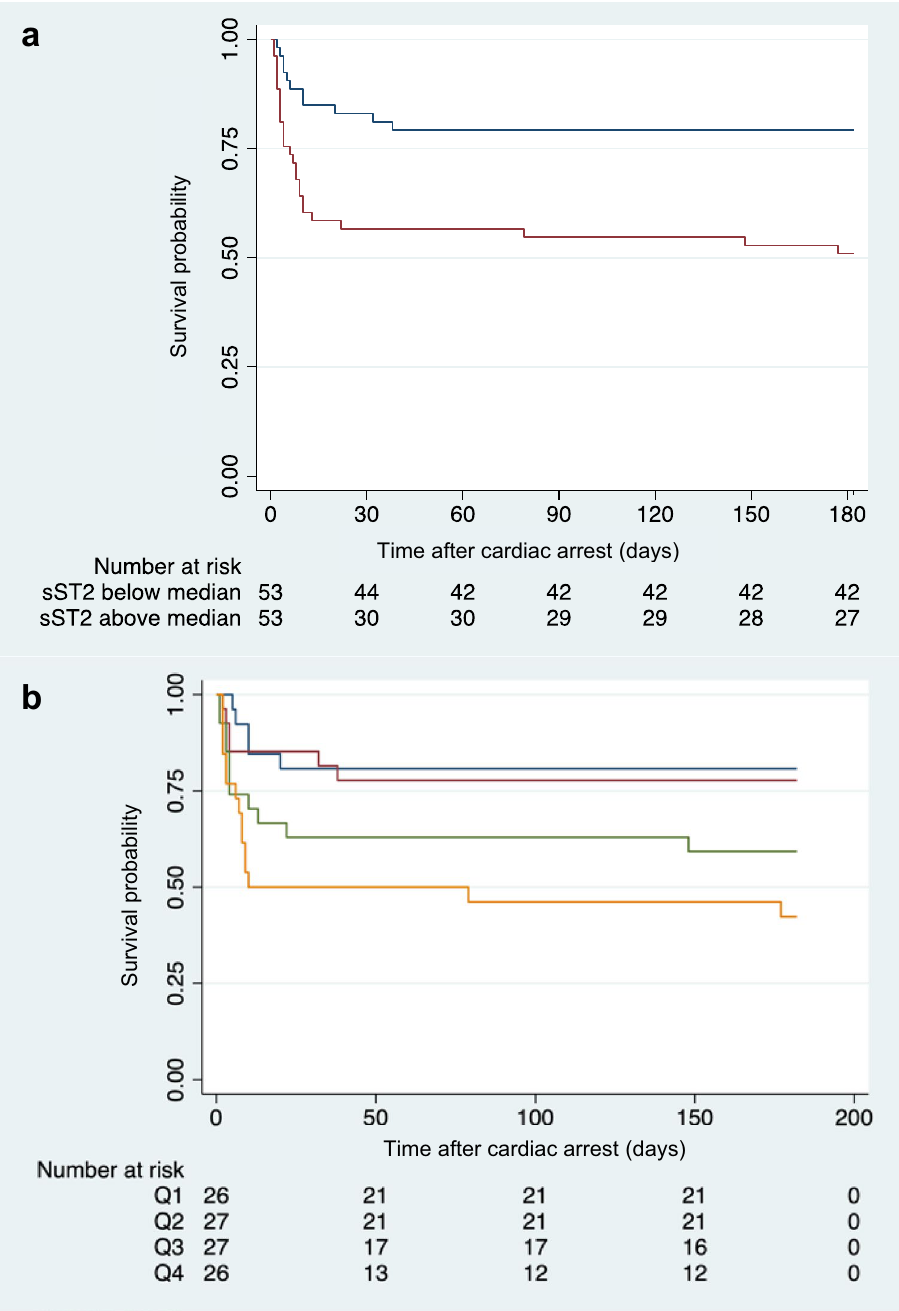
Figure 3. ( a ) Kaplan–Meier plot for patients with sST2-levels below (red line) and above the median (blue line; median sST2-level 24 h after admission: 53.42 ng/ml). ( b ) Kaplan–Meier plot for patients stratified by sST2-level quartiles (blue line: quartile 1, sST2 < 34.68 ng/ml; red line: quartile 2, sST2 ≥ 34.68 ng/ml and < 53.42 ng/ml; green line: quartile 3, sST2 ≥ 53.42 ng/ml and < 93.57 ng/ml; yellow line: quartile 4, sST2 ≥ 93.57